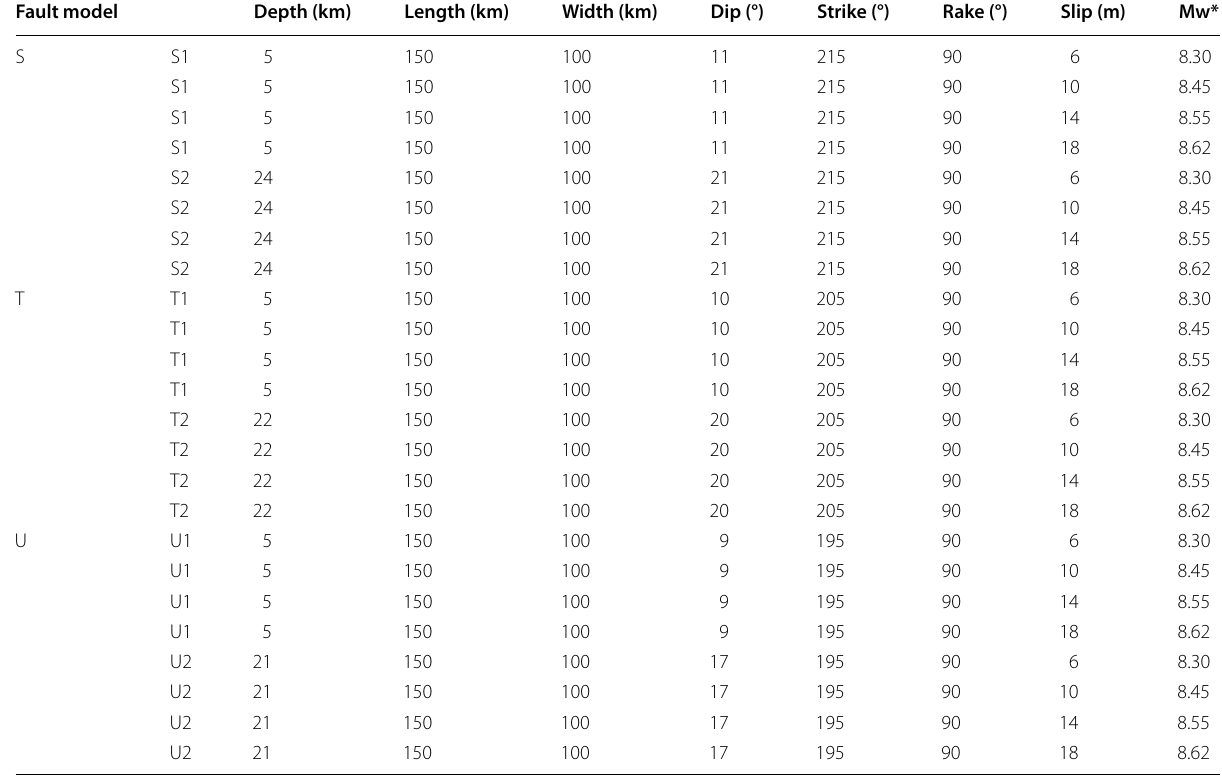
*Rigidity is assumed to be 40 GPa